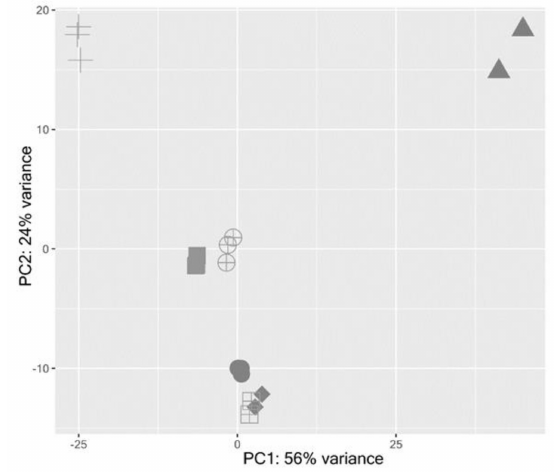
Figure 2. The application of transcriptomics to define drug mode of action. Principle Component Analysis (PCA) of M.tb responses to seven di ff erent drugs (represented by shapes) derived from RNAseq of 2–3 biological replicates per drug. M.tb mRNA signatures from antimicrobial drugs with similar mechanisms of action will cluster